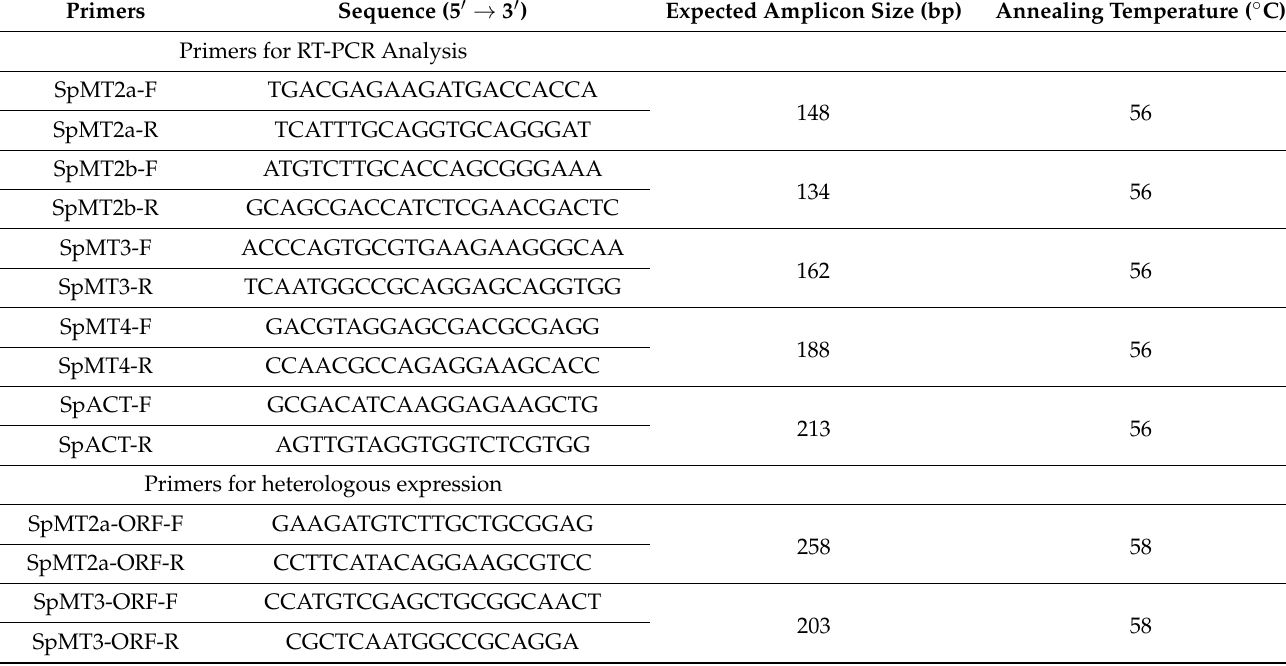
Table 2. Oligonucleotide primers used in the